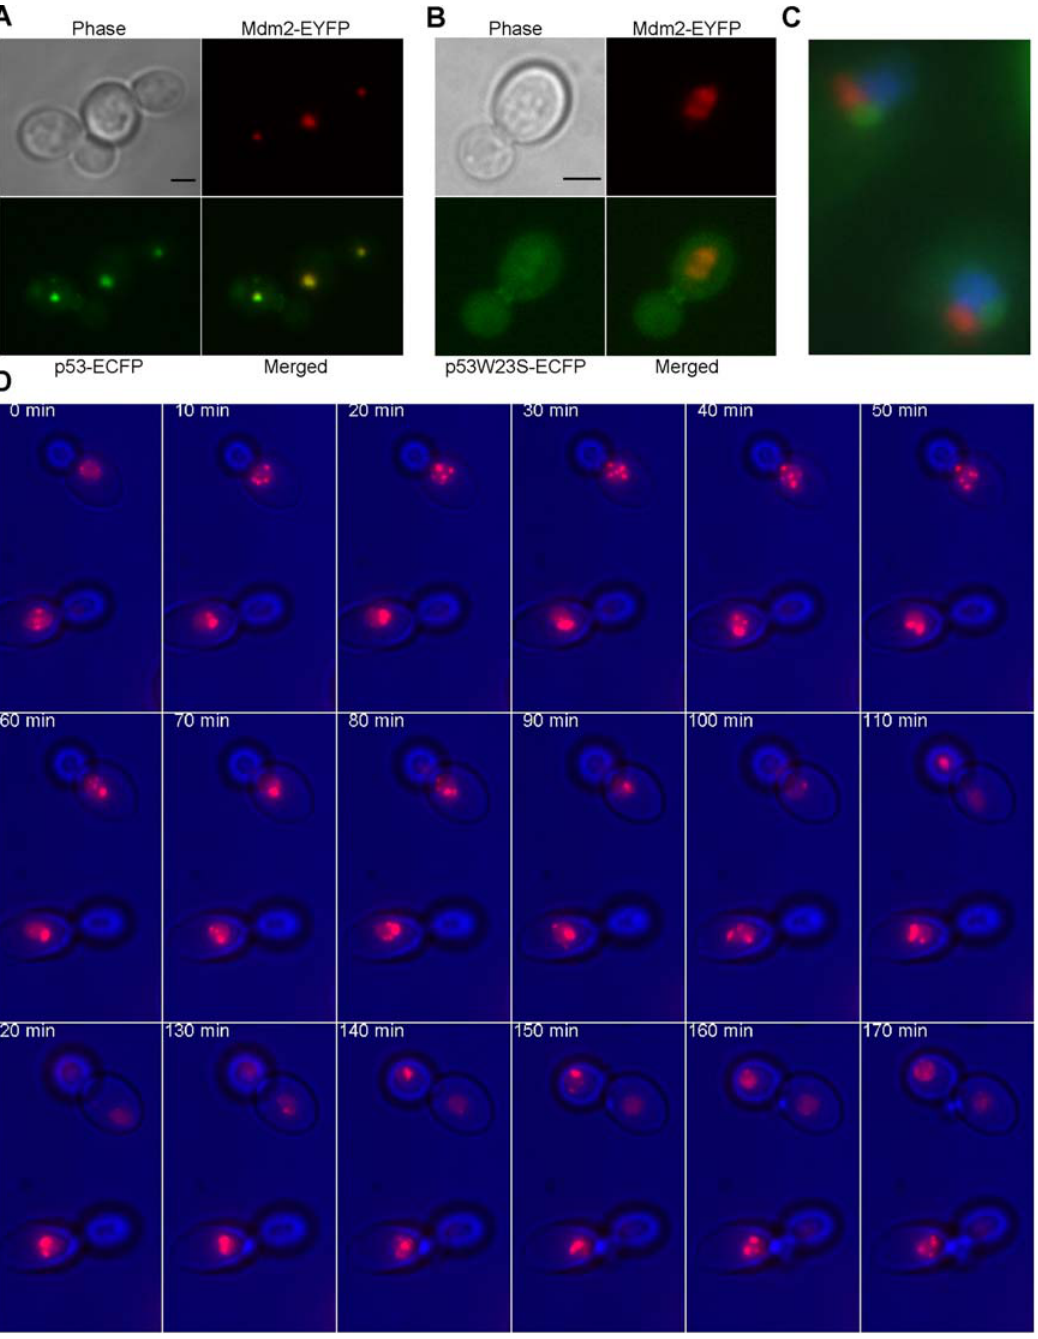
Figure 3. p53 and Mdm2 co-localize in yeast cells. ( A,B) Maximum projections from fluorescence image stacks of live yeast cells expressing the indicated fusion proteins were obtained with a DeltaVision workstation. Bar, 2 m m. (C) Indirect immunofluorescence of fixed yeast cells stained for p53-Mdm2 bodies (primary antibody: goat polyclonal N-19 anti-p53; secondary antibody: Cy2-labeled donkey anti-goat; showed in green), Nop1 (primary antibody: mouse monoclonal; secondary antibody: Cy5-labeled donkey anti-mouse; showed in red) and chromatin (detected with Ho¨echst, showed in blue). (D ) Time-lapse microscopy on yeast cells expressing p53 and Mdm2 obtained recording image stacks and then performing maximum projections of live yeast cells at the indicated times. Galactose was added directly into the Petri dish to trigger p53 expression and time- lapse started shortly after. Mdm2 is shown in red and the phase-contrast image of the cells in blue.